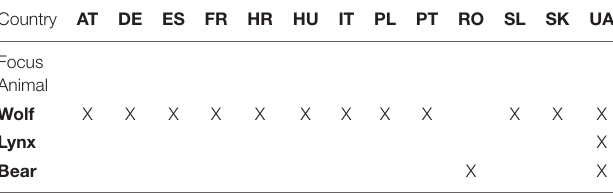
TABLE 6 | Focus animals of stakeholder maps per country.